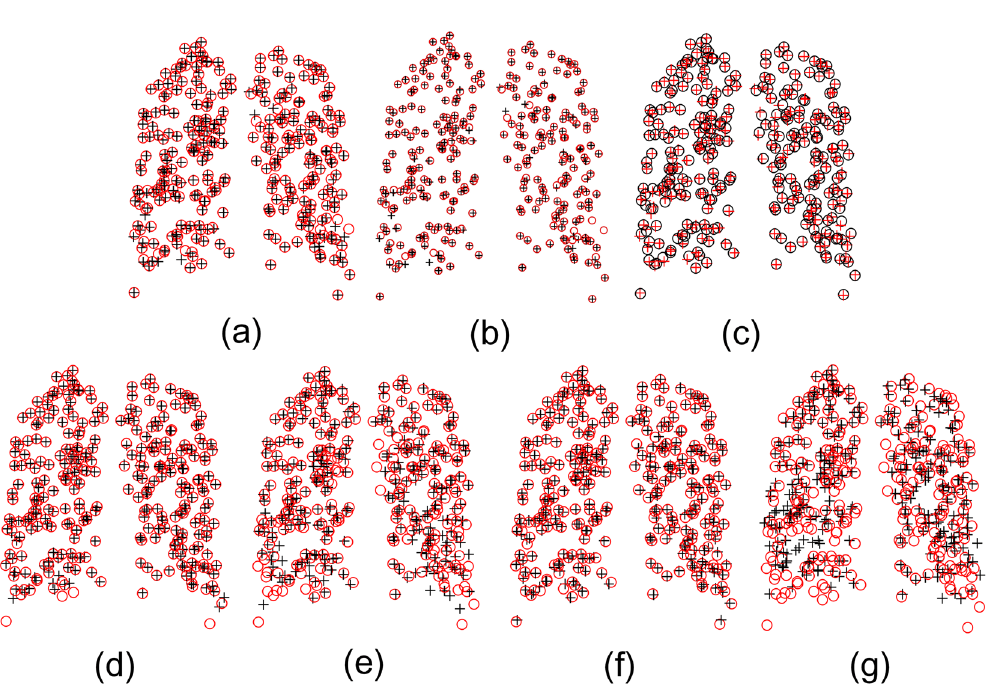
Figure 8. Performance of non-rigid point set registration algorithms on the point set extracted from COPD, which is shown in Fig. 6(b). ( a – f ) show the final registration results of DSMM, PR-GLS, pSMM, GMM-L2, CPD, RBF-RPM, and TPS-RPM